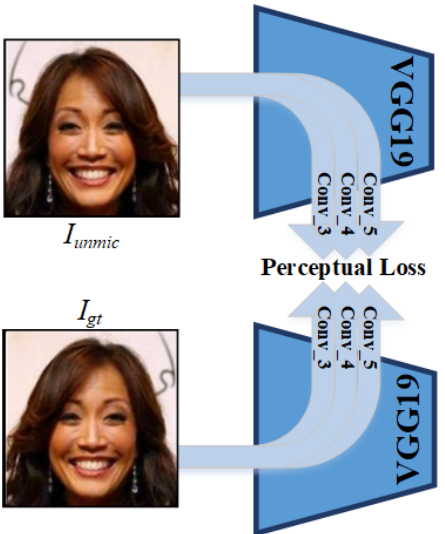
Figure 3. Perceptual loss calculation from the pre-trained loss network